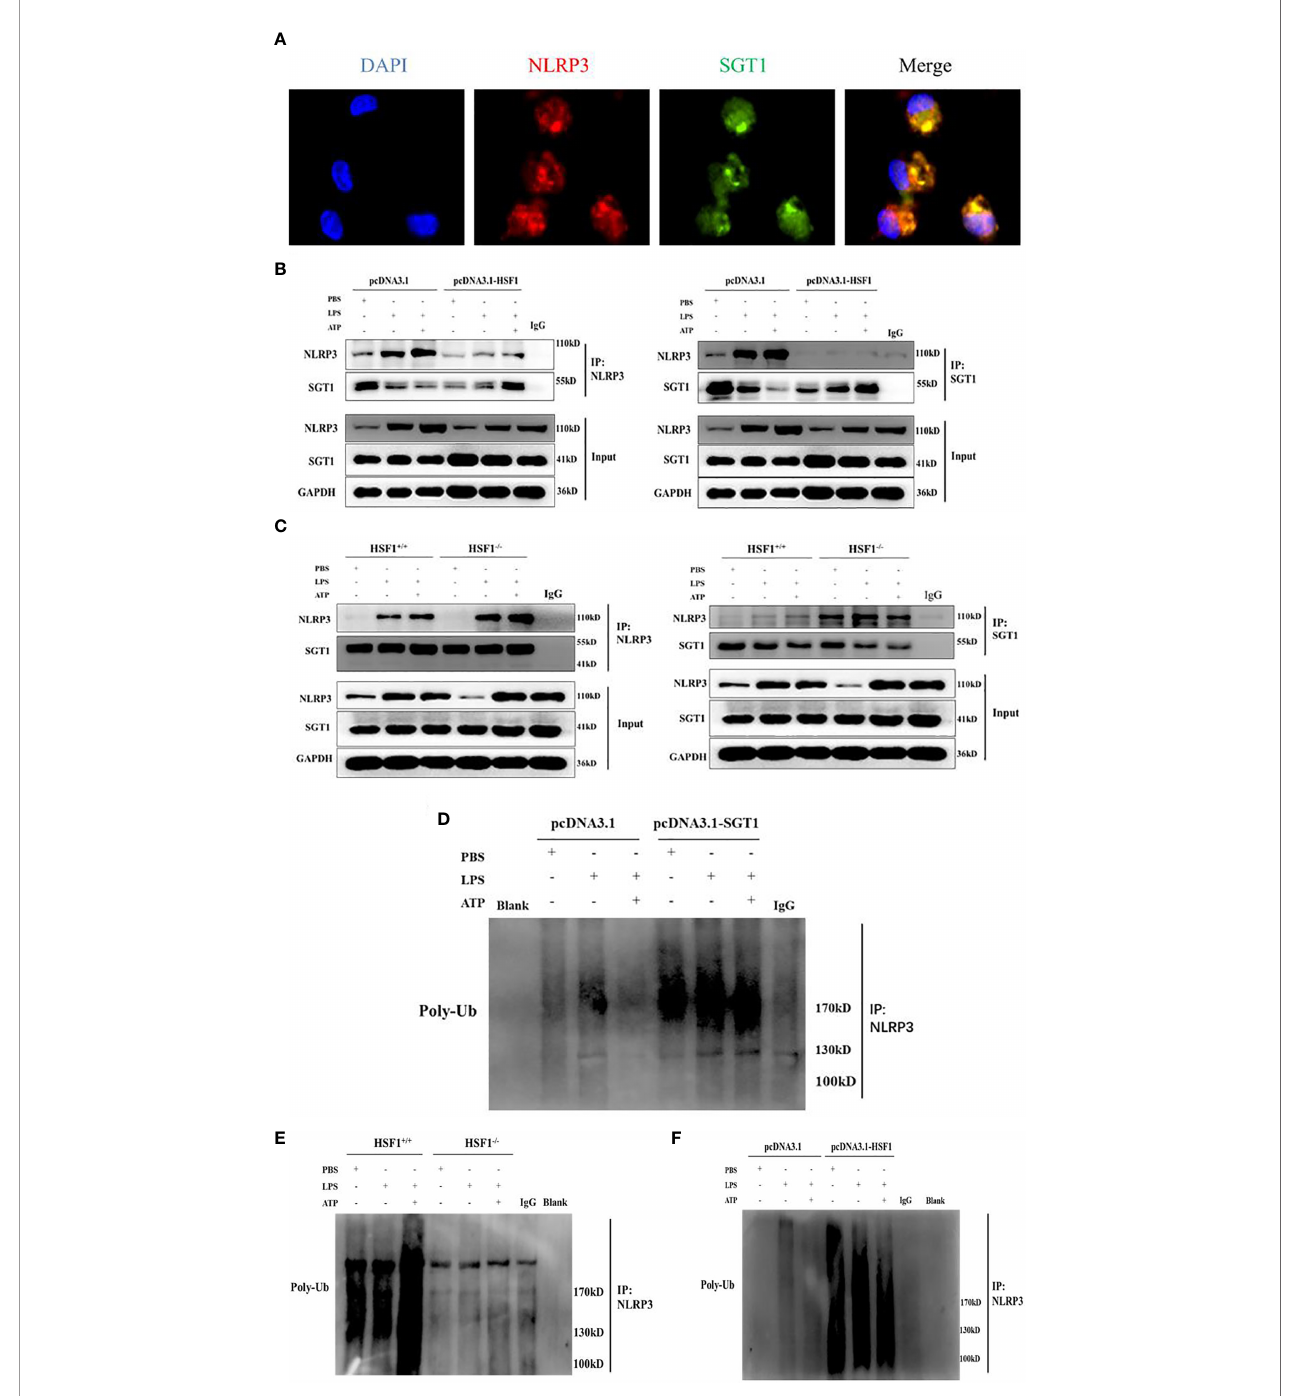
FIGURE 6 | HSF1 inhibited the NLRP3 in fl ammasome activation by increasing the ubiquitination of NLRP3. (A) Expression and localization of NLRP3 and SGT1 in primary peritoneal macrophages were detected by immuno fl uorescence. Green and red colors represent SGT1 and NLRP3, respectively; blue represents nuclei. Merge (yellow) in the overlay images indicates co-localization. (B) The effects of HSF1 overexpression on the interaction between NLRP3 and SGT1 in LPS3h (1 m g/ ml) and ATP (5.0 mM) induced RAW264.7 cells. (C) The effects of HSF1 knockout on the interaction between NLRP3 and SGT1 in LPS3h (100 ng/ml) and ATP (2.5 mM) induced primary peritoneal macrophages. (D) The effect of SGT1 overexpression on the ubiquitination of NLRP3 in LPS3h (1 m g/ml) and ATP (5.0 mM) induced RAW264.7 cells. (E) The effect of HSF1 overexpression on the ubiquitination of NLRP3 in LPS3h (1 m g/ml) and ATP (5.0 mM) induced RAW264.7 cells. (F) The effect of HSF1 knockout on the ubiquitination of NLRP3 in LPS3h (100 ng/ml) and ATP (2.5 mM) induced primary peritoneal macrophages. Data are representative or means (SD) of at least three independent